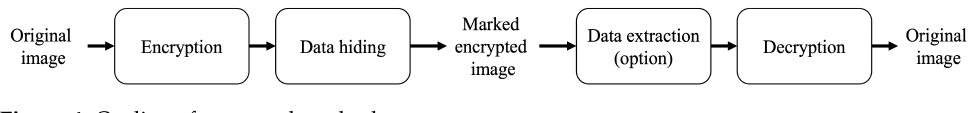
Figure 4. Outline of proposed method.